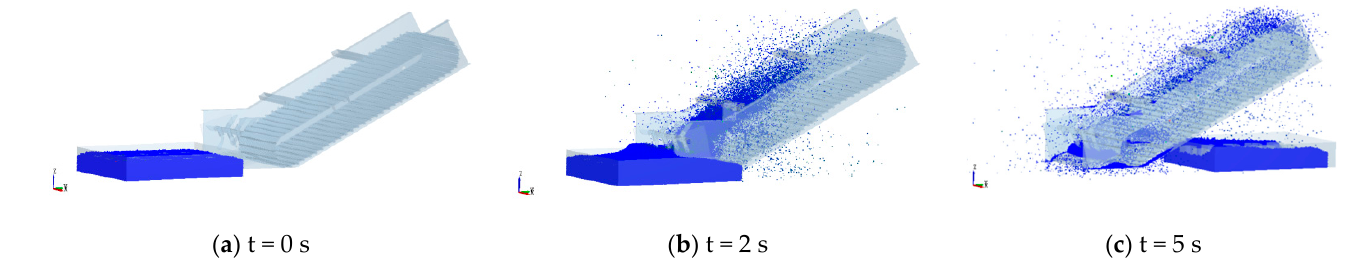
Figure 8. Simulation process of excavation, hoisting device: ( a ) t = 0 s; ( b ) t = 2 s; and ( c ) t = 5 s.